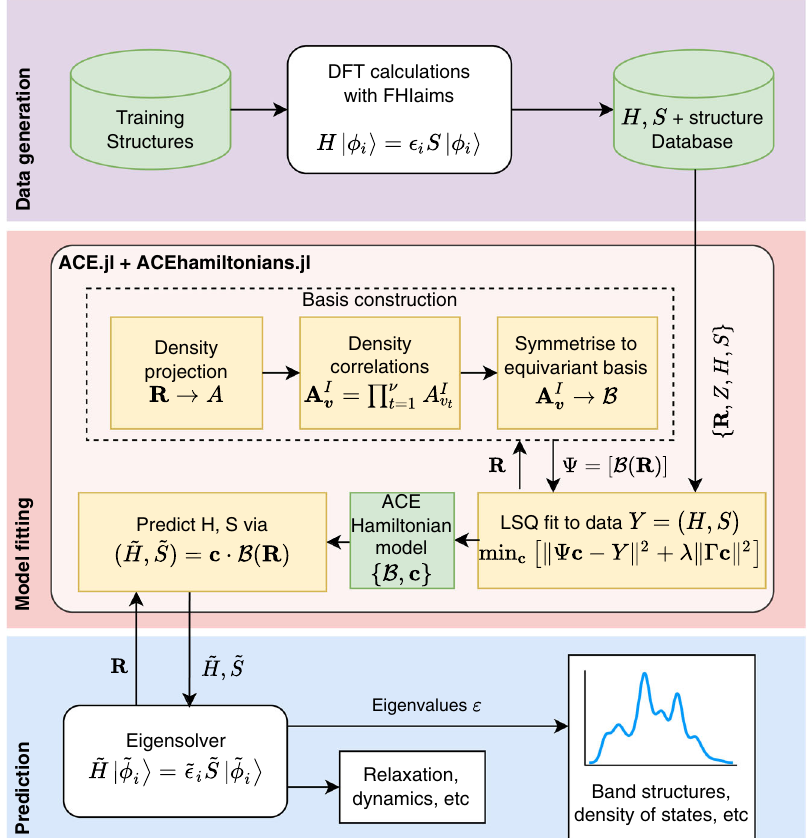
Fig. 1 Schematic of the ACEhamiltonians (atomic cluster expansion for Hamiltonians) work fl ow. The upper panel shows data generation with the FHI-aims electronic structure theory code, the central panel model fi tting with the ACE.jl and ACEhamiltonians.jl packages, and the lower panel prediction.